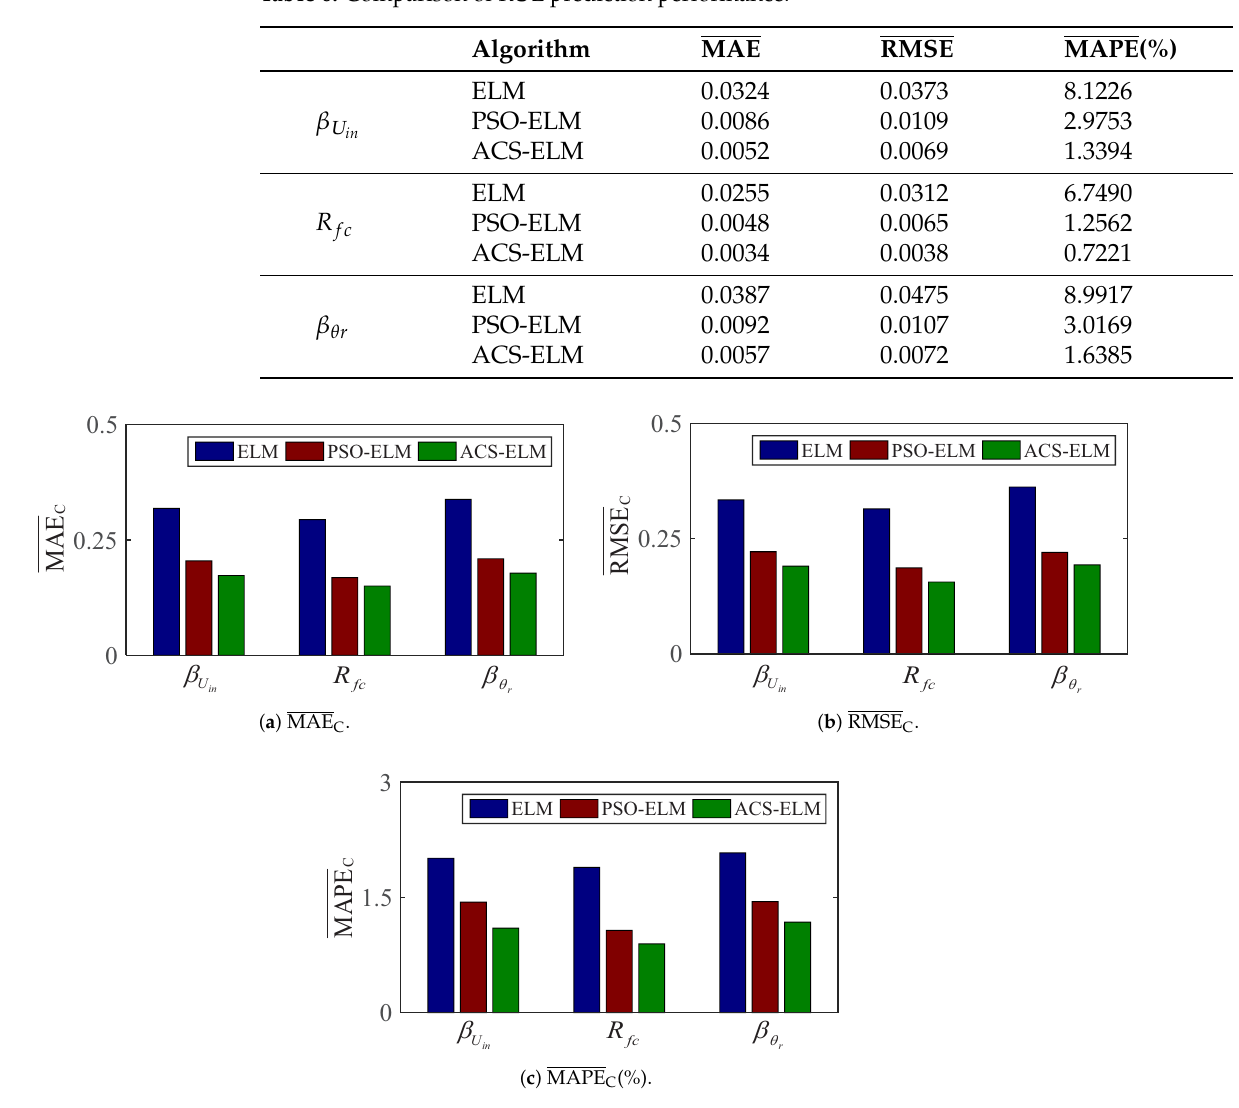
Figure 11. Histogram of RUL prediction